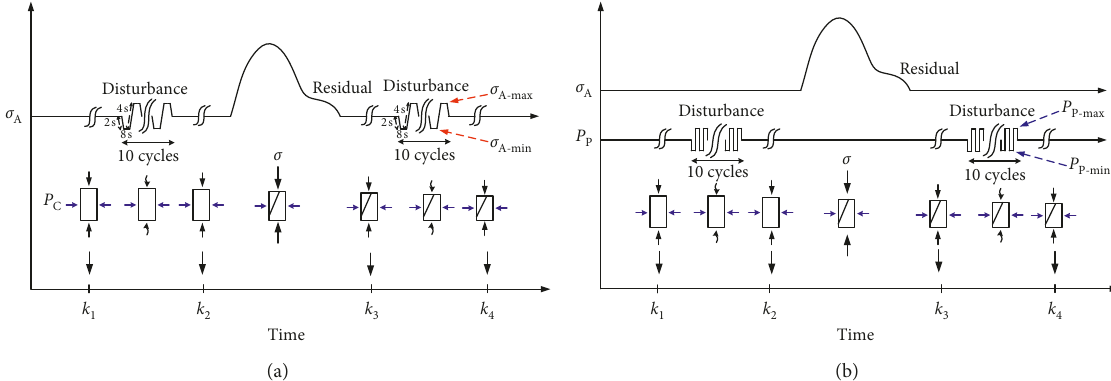
Figure 4: Experimental procedure for the Shikotsu welded tuff. (a) Axial stress disturbances; (b) pore pressure